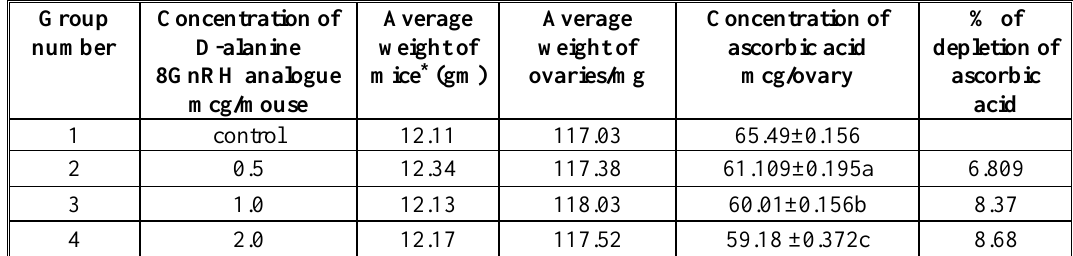
Table 3: Average weight of pseudo pregnant mice ovaries, concentration of ascorbic acid, and percent of depletion of ascorbic acid in treated groups by analogue (II):